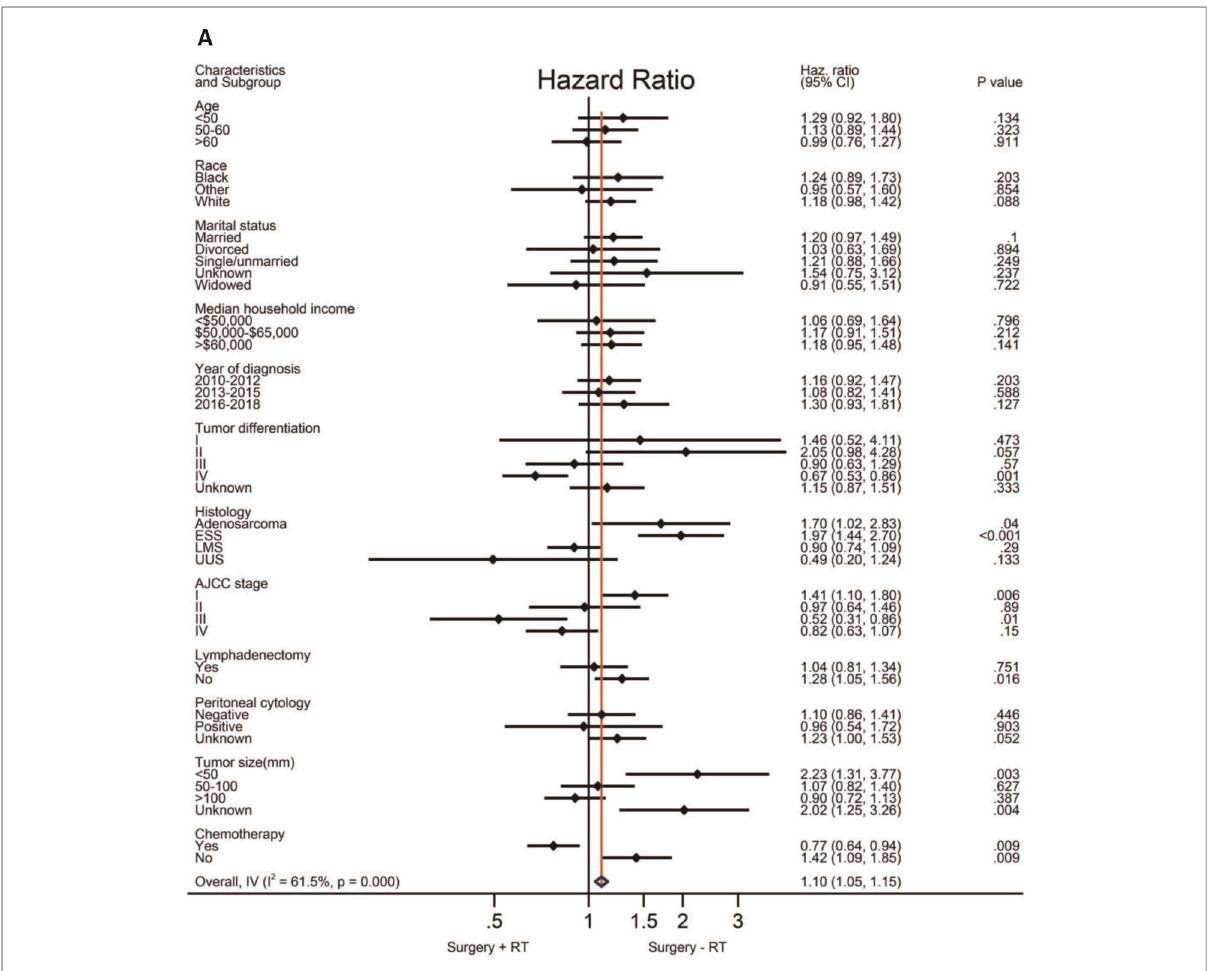
FIGURE 2 Exploratory subgroup analysis concerning radiotherapy impact on survival outcome in the whole cohort. ( A ) Cause-speci fi c survival before IPTW- adjustment. ( B ) Overall survival before IPTW-adjustment. ( C ) Cause-speci fi c survival after IPTW-adjustment. ( D ) Overall survival after IPTW- adjustment. CI: con fi dence interval; HR: hazard ratio; LMS: leiomyosarcoma; ESS: endometrial stromal sarcoma; USS: undifferentiated uterine sarcoma; IPTW: inverse probability of treatment weighting. The vertical solid-line refers to a hazard ratio of 1.0. HR<1 favors surgery followed by radiotherapy and HR>1 favors surgery without radiotherapy administered. P <0.05 indicates statistical signi fi